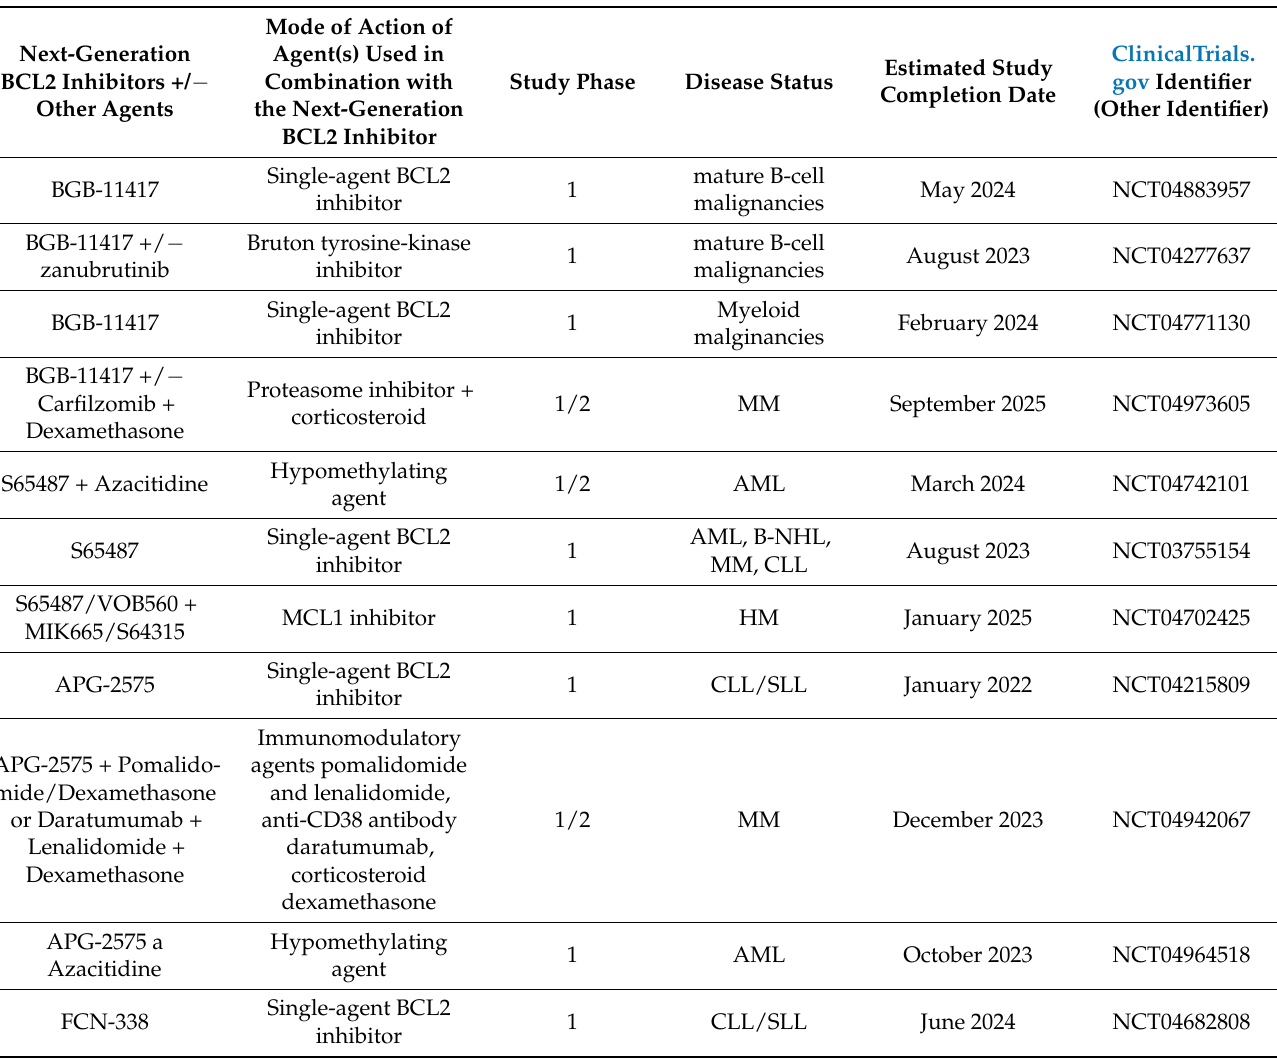
Table 5. Selected clinical trials that incorporate next-generation BCL2 inhibitors in experimental therapy of hematologic